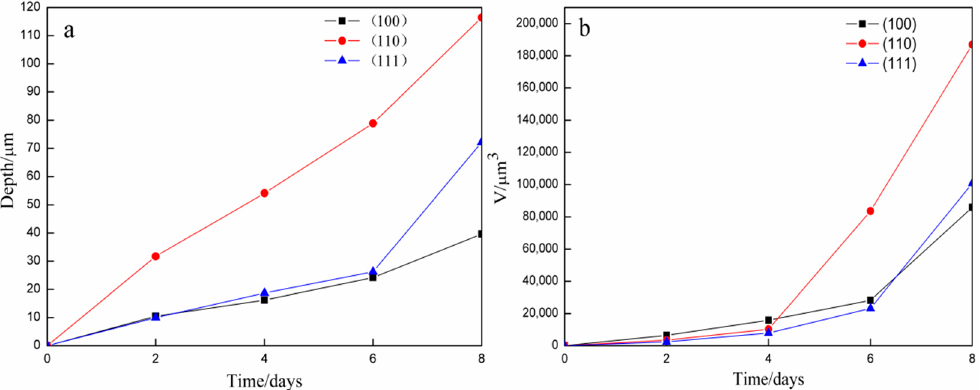
Figure 4. Crystal direction depth and volume changes of etching pits. ( a ) Depth changes, and ( b ) volume changes.